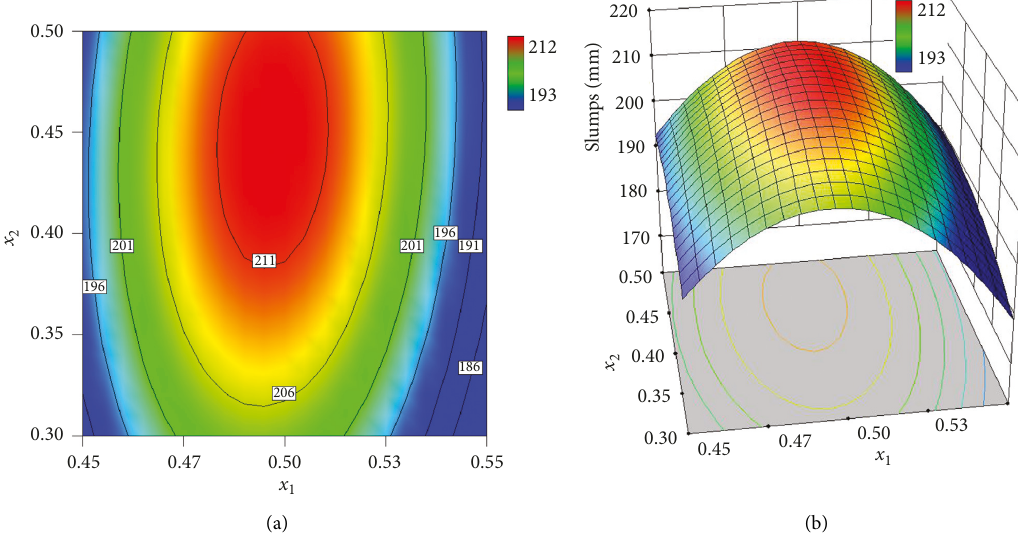
Figure 10: Interaction influence of x 1 and x 2 on slump. (a) Two-dimensional diagram. (b) Three-dimensional diagram.